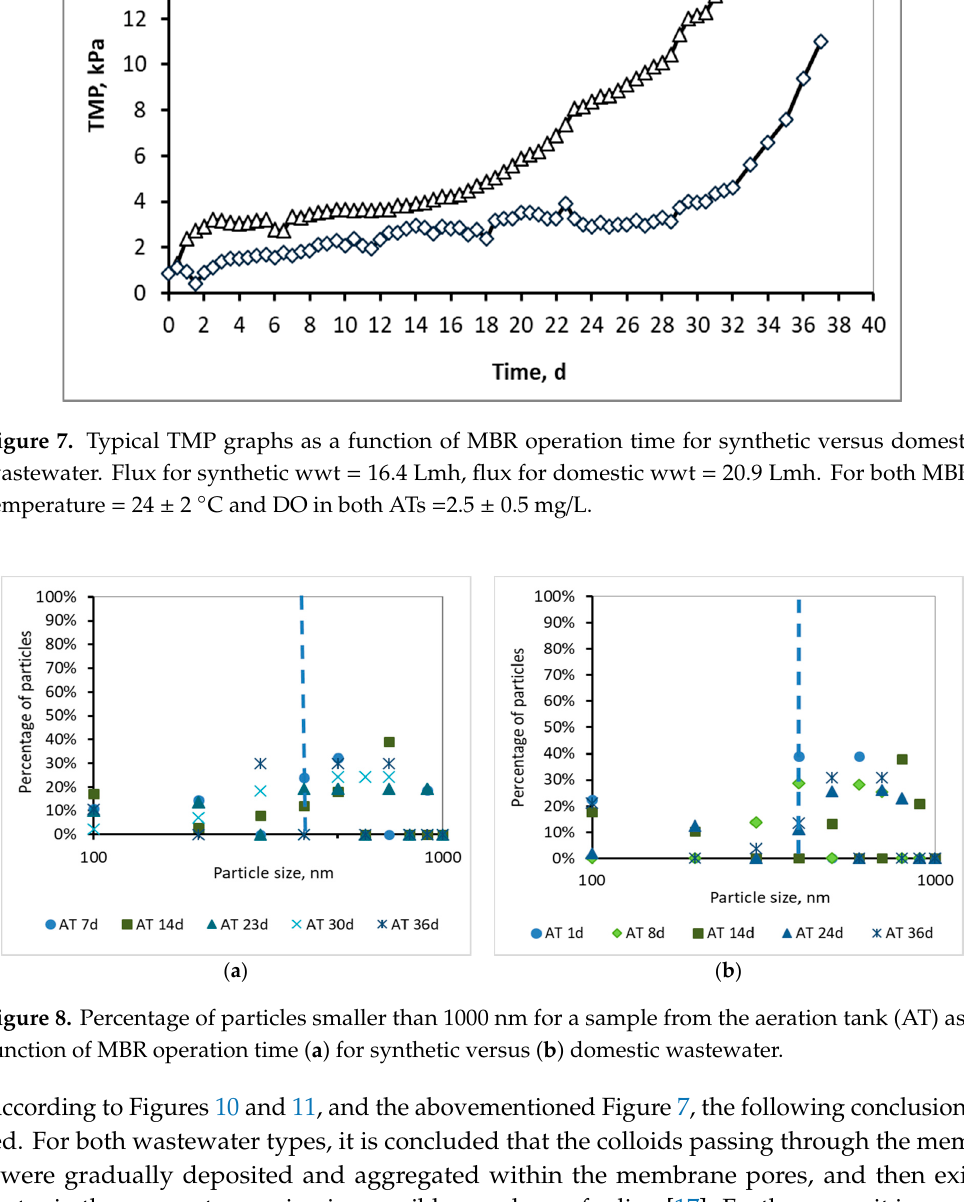
Figure 7. Typical TMP graphs as a function of MBR operation time for synthetic versus domestic wastewater. Flux for synthetic wwt = 16.4 Lmh, flux for domestic wwt = 20.9 Lmh. For both MBRs